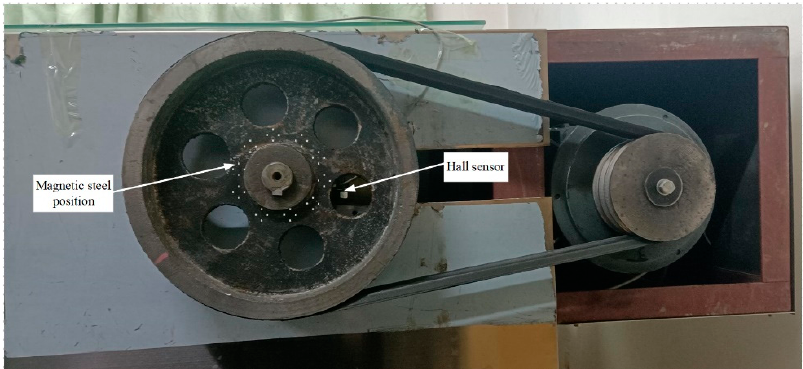
Figure 12. Schematic diagram of seedbed belt speed detection. The field experiment was conducted in Xiangshui County, Yancheng City, Jiangsu